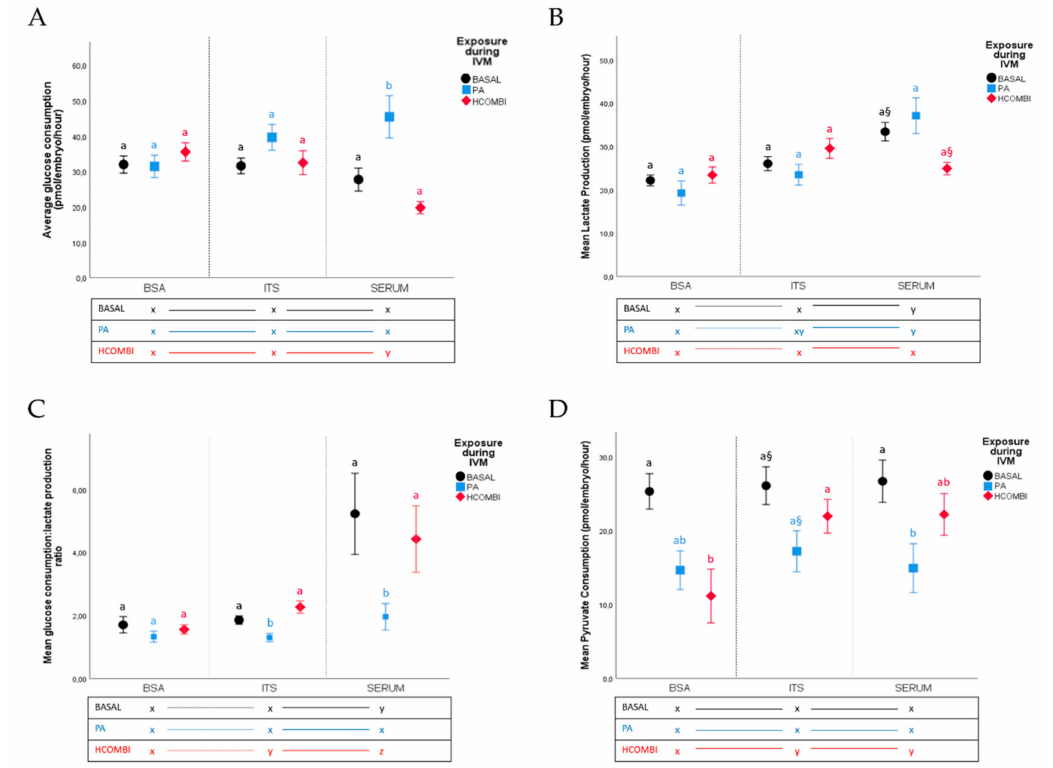
Figure 2. The e ff ect of BSA, ITS or serum supplementation during IVC on ( A ) average glucose consumption, ( B ) lactate production, ( C ) lactate:(2 glucose) ratio and ( D ) pyruvate consumption (pmol / embryo / hour) of blastocysts resulting from BASAL-, PA- or HCOMBI-exposed oocytes. Data are presented as mean percentage ± SEM. Vertical superscripts (a, b) indicate significant di ff erences between maturation conditions within the same IVC condition ( p < 0.05). Horizontal superscripts (x, y, z) indicate significant di ff erence between culture conditions within the same IVM condition ( p < 0.05). Values labeled with “§” tend to be di ff erent from each other at p < 0.1 and >